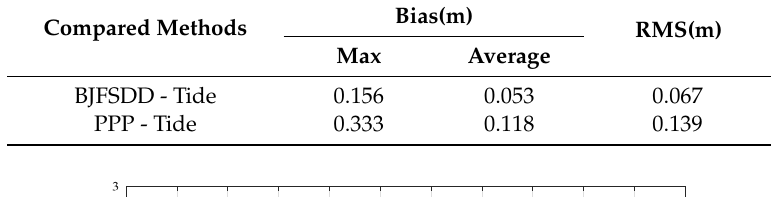
Figure 12. Comparison of the DD tide based on the BJFS and PPP tide with tide gauge data.